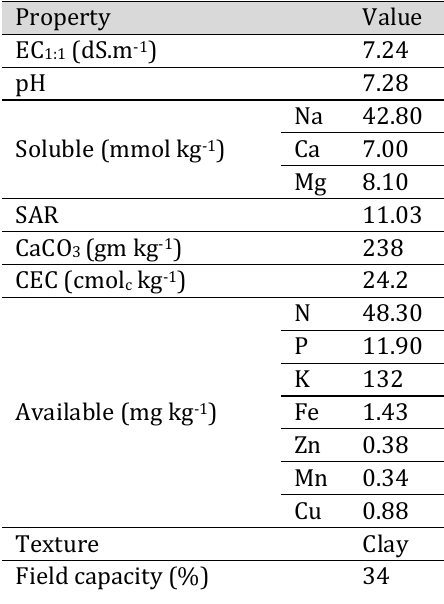
Table 1. Som e of the chemical and physical p roperties (0 -30cm) of the s